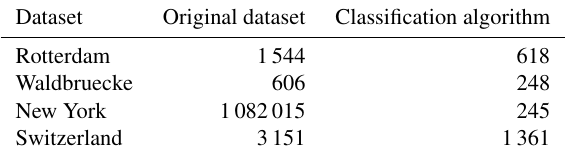
Table 3: Classification accuracy.